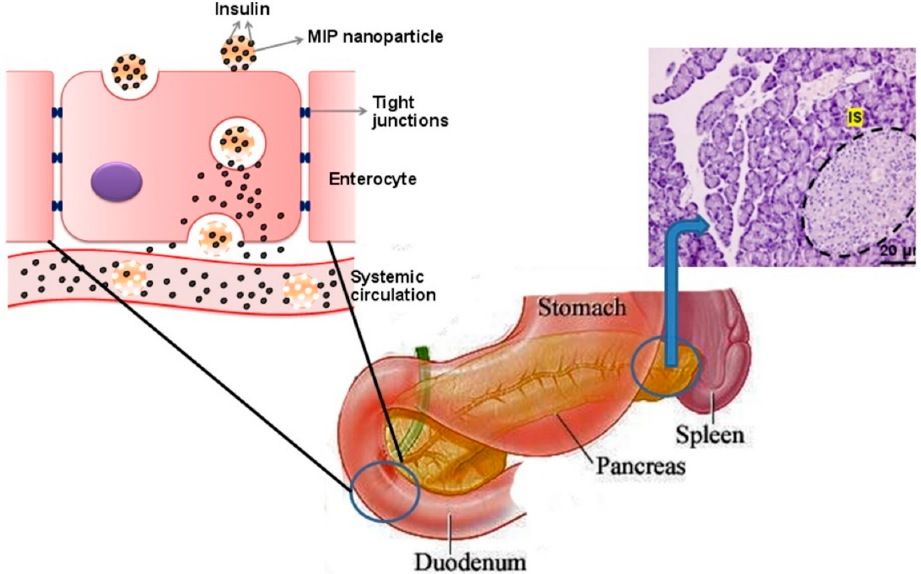
Figure 5. Schematic of the transport of insulin-loaded MIP NPs across the intestinal epithelial cells through the oral route and of the insulin release by endocytosis and transcytosis through the enterocytes, supplementing the lack of function of pancreatic beta cells. Reproduced with permission from Paul et al. [100].